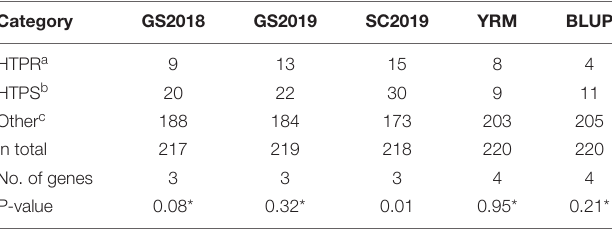
TABLE 2 | The number of resistance genes that confer adult plant resistance to stripe rust calculated by Mendelian segregation ratios in Huixianhong/Pascal recombinant inbred lines